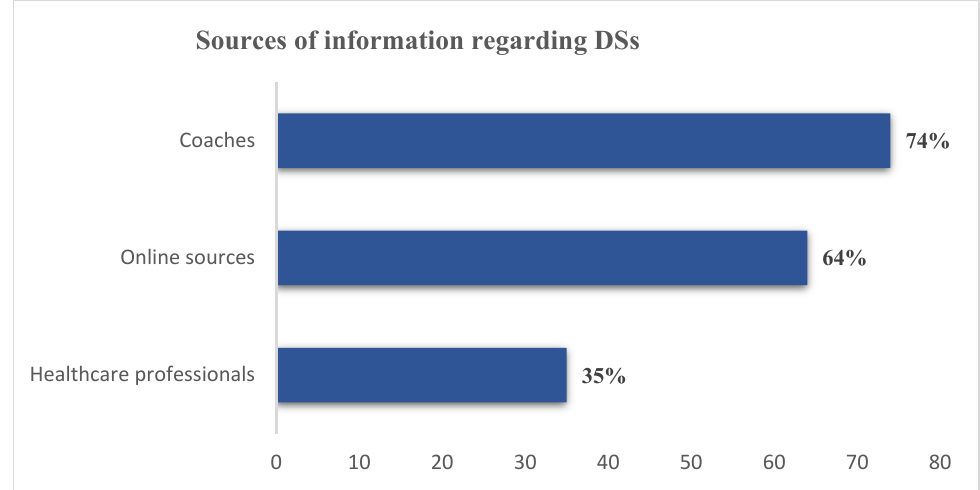
Figure 2. Sources of information regarding DSs. Table 2. The athletes’ responses to the knowledge, attitudes, and practices (KAPs)